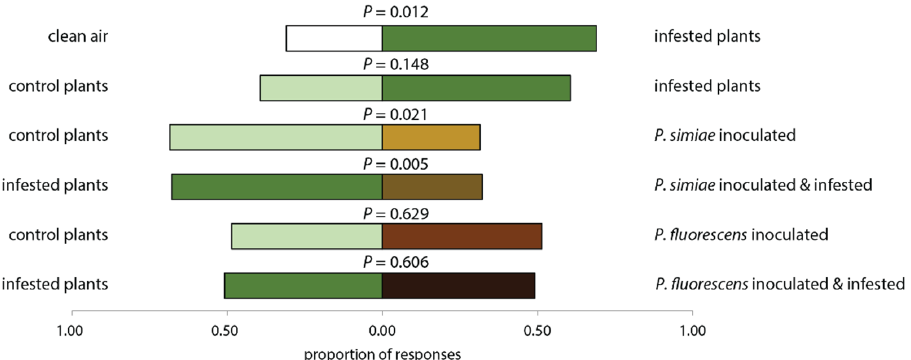
Figure 2. Proportion of spined soldier bug Podisus maculiventris responding to odor sources in pairwise choice assays. Tomato plants ( Solanum lycopersicum ) were exposed to inoculation with one of two strains of rhizobacteria and herbivory by Spodoptera littoralis. 5–10 bugs were tested per pair of plant with 6–8 replicates of each plant pair. Pairwise comparison of treatments with binomial test. The odor profile of tomato plants comprised 25 compounds, including 15 monoterpenoids, 7 sesquiterpenoids, the homoterpene ( E,E )-Trideca-1,3,7,11-tetraene, 4,8,12-trimethyl, and nitrogen O-methyloxime-3-